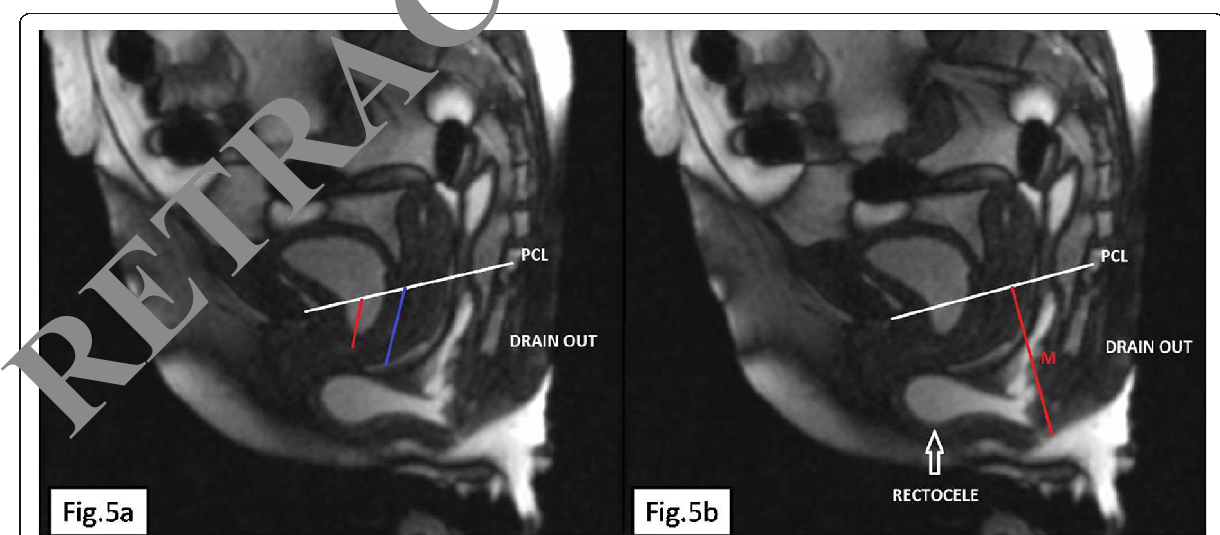
Fig. 5 Descent of all the compartments. Terminal drain out (defecation phase) of same patient as in Fig. 4 reveals descent of bladder neck (red line) and cervix (blue line) ( a ). Same patient also shows severe ano-rectal junction decent (red line) with retention of jelly in anterior rectocele (white arrow) ( b ). This picture highlights the role of running the defecation phase imaging for a sufficient time to demonstrate the full